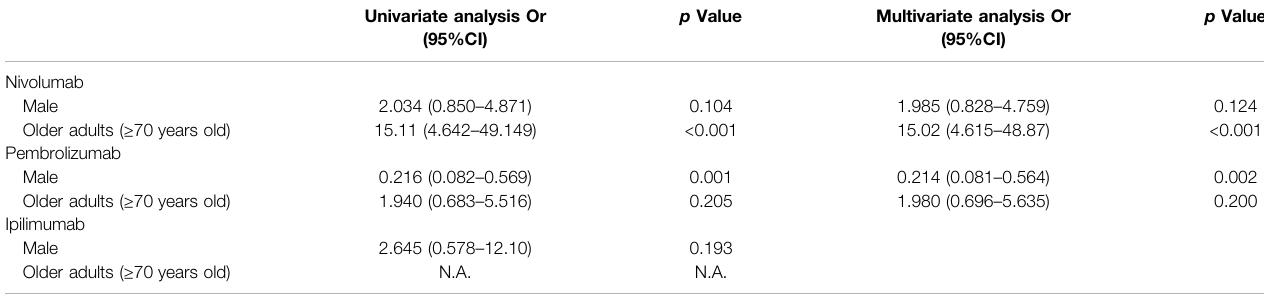
TABLE 7 | Univariate and multivariate analysis for predictors of ICPI-induced polymyalgia rheumatica.